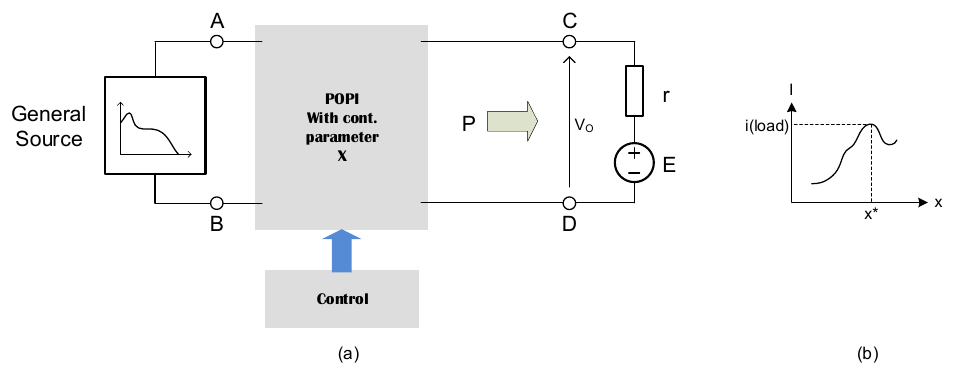
Figure 12. ( a ) A general source coupled to the load by means of POPI with cont. parameter, X . ( b ) The load current as a function of X .